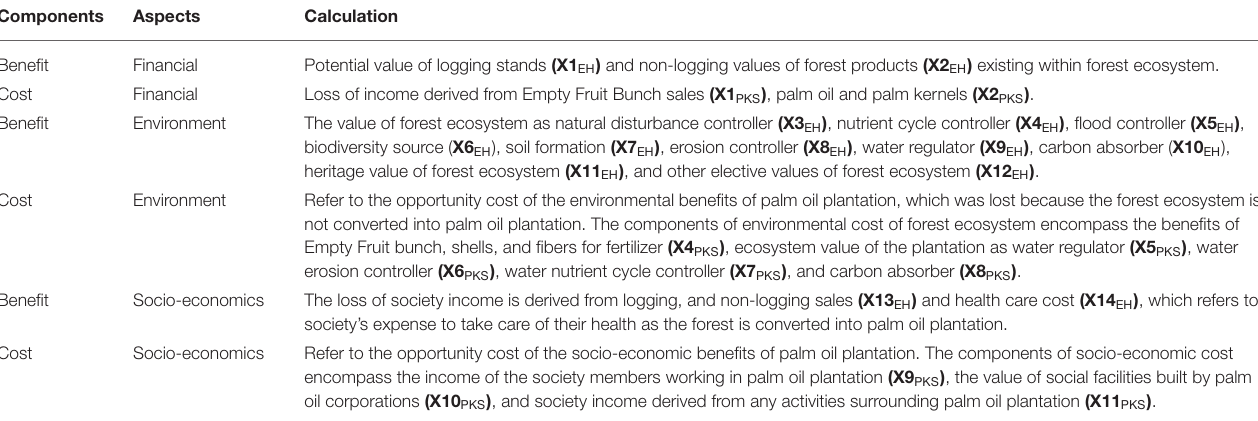
TABLE 3 | Cost-benefit components of forest ecosystem.